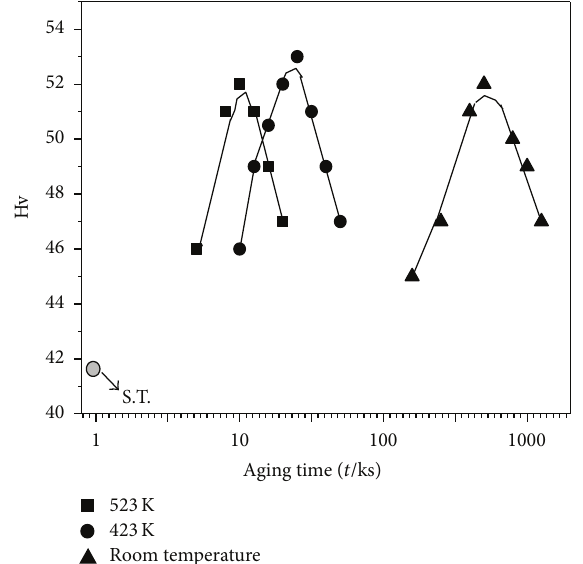
Figure 2: Hardness versus aging time for the aged LZ101 alloy [9].